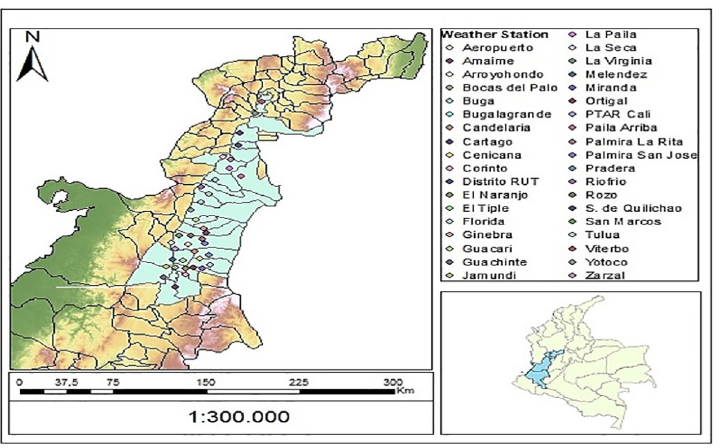
Fig 1. Cenica ñ a’s weather stations in the Cauca River Valley (CRV),